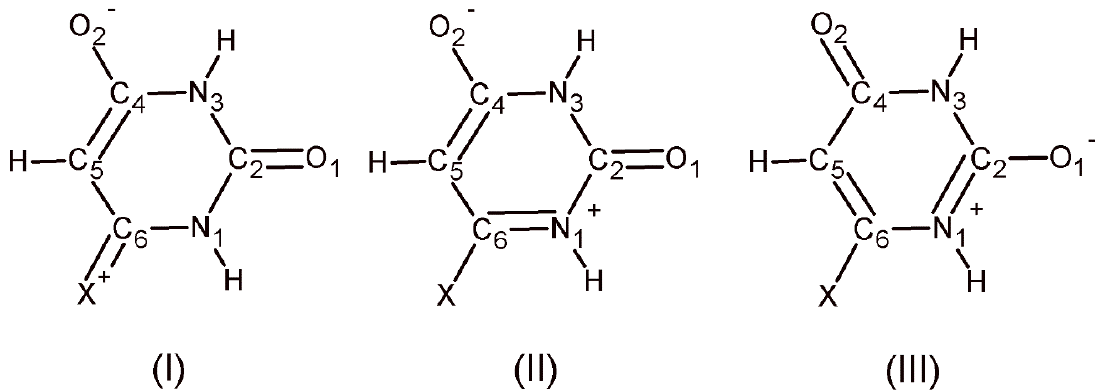
Figure 3. Possible polar canonical forms for compounds 5–7.